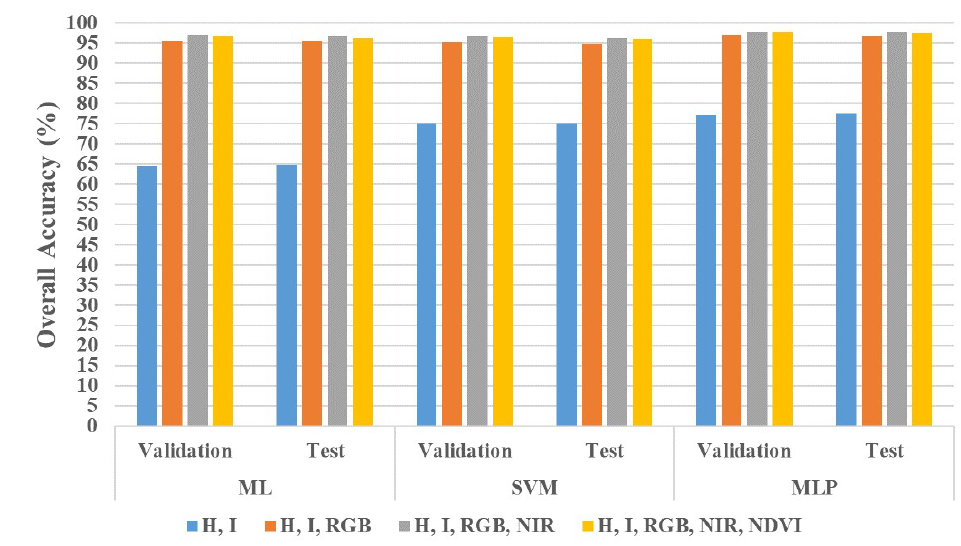
Figure 12. Classification results on validation and test sets (ML: Maximum Likelihood, SVM: Sup- port Vector Machine, H: Height, I: Intensity, RGB: Red Green Blue, NDVI: Normalized Difference Vegetation Index).